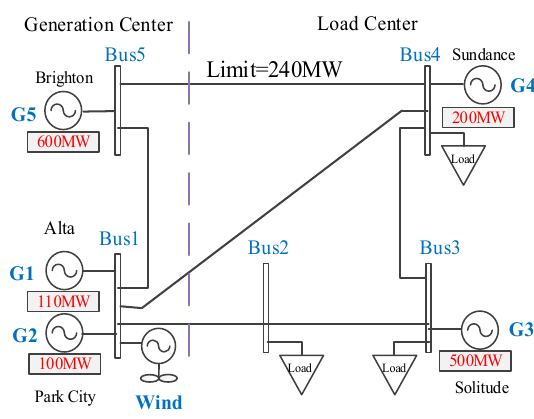
Figure 2. Modified PJM 5 ‐ bus system.